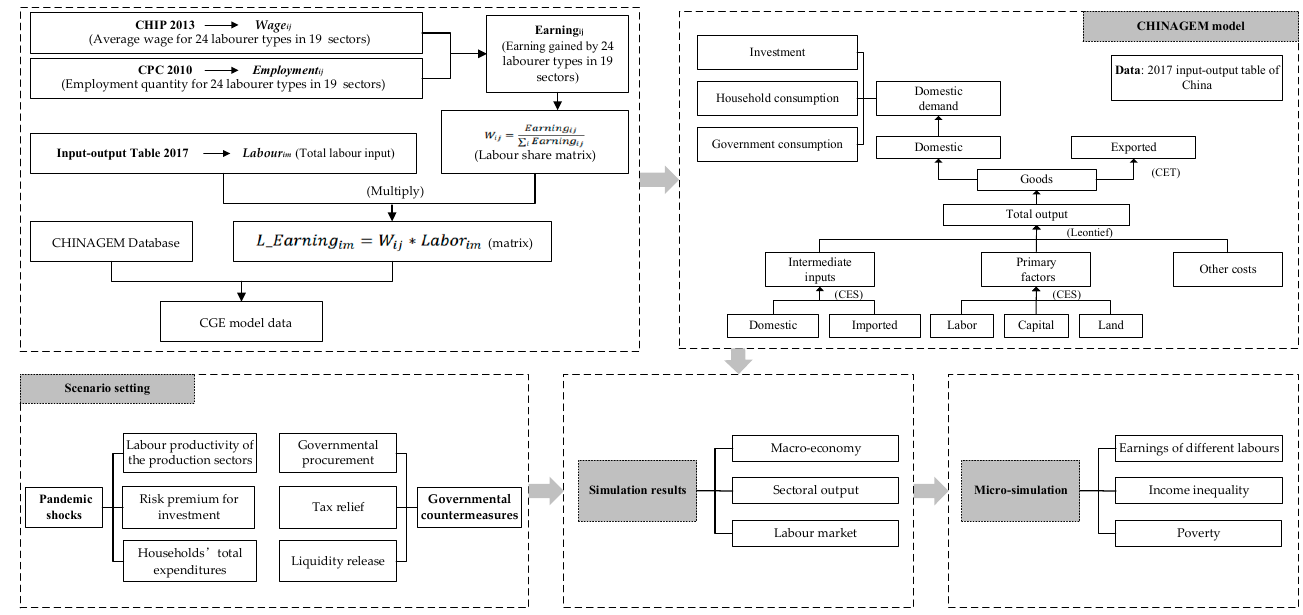
Figure 1. The flow chart of this study. Source: the authors.